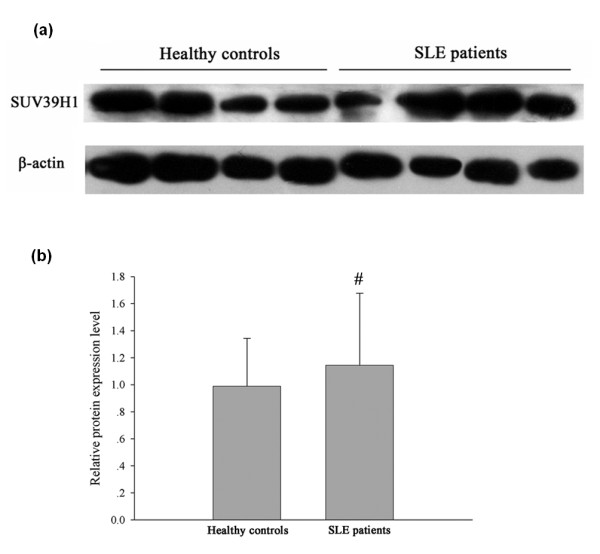
SUV39H1 protein levels from SLE patients (n = 15) and healthy controls (n = 15) measured by Western blot. (a) Representative blots of SUV39H1 and β-actin (loading control) in SLE patient and healthy control CD4+ T cells (n = 4 per group). (b) Quantitative analysis of SUV39H1 band intensities normalized to β-actin (#, P > 0.05).